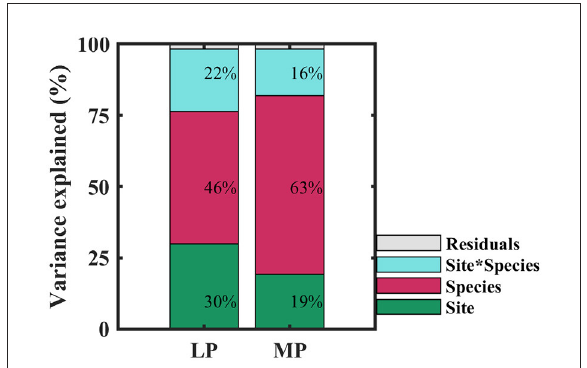
FIGURE3 Contributions of species (red), site (green), and their interaction (blue) to variation in intrinsic water use efficiency. LP, Loess Pleateau; MP, Inner Mongolia Plateau.